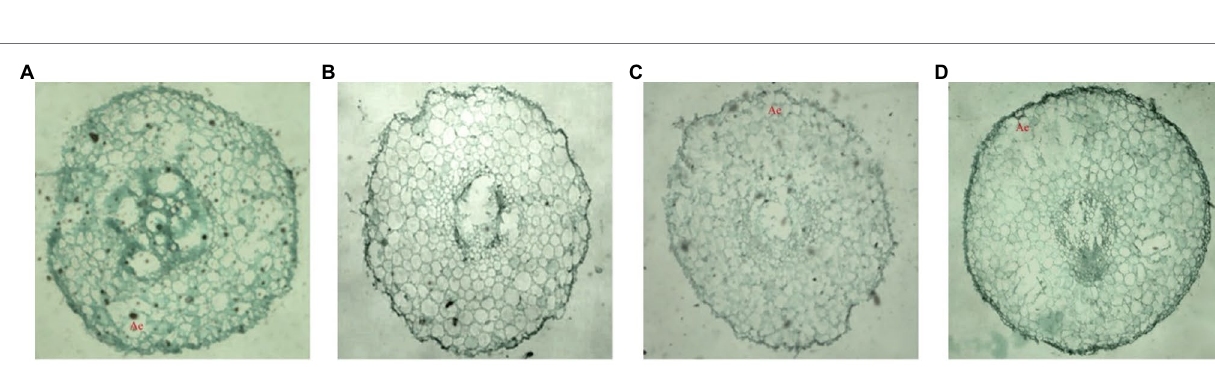
FIGURE 1 | Morphological differences between two treated peanut cultivars and their controls. (A) The peanut taproots of treated and the control groups after 22 days of waterlogging treatment. Left two samples were treated ones, and the right one was control sample; (B) the peanut hypocotyl produced adventitious roots in Zhonghua 4 (ZH4) after 22 days waterlogging treatment; and (C) the peanut epicotyl produced adventitious roots in Xianghua08 (XH08) after 22 days of waterlogging treatment.